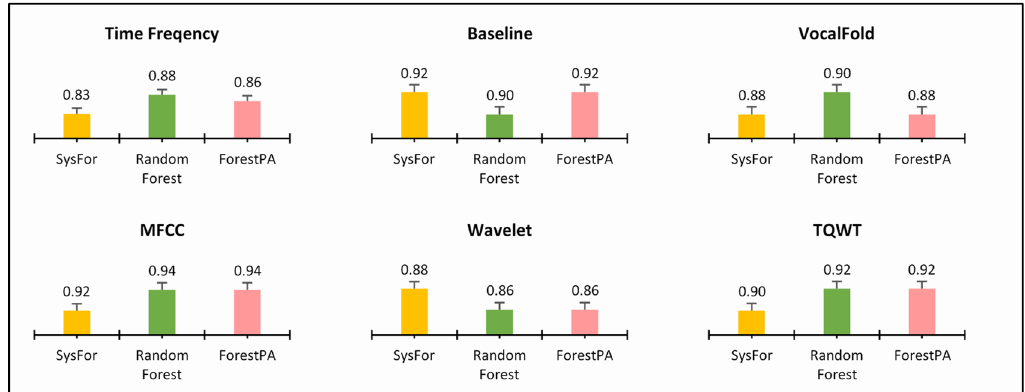
Figure 5. Highest sensitivity of decision forest algorithms with minimum number of trees on various feature of Istanbul acoustic dataset.